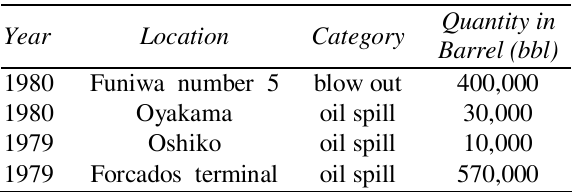
Table 3: Some Recorded Cases of Oil Spillage on the Delta from 1979-1980